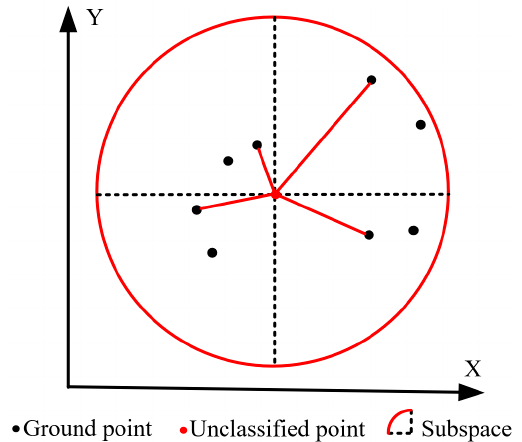
Figure 8. Schematic diagram of the identification for evenly distributed neighbor ground points. The implementation steps include point cloud attribute initialization, ground seed identification, and ground point extraction. First, the attributes of all points in the point cloud are marked as unclassified points. Second, unclassified points are regarded as ground seeds if the distances between the points and the detected planes are less than a buffer difference threshold. The attributes of identified ground seeds are modified to ground points. Third, the neighbor ground points of an unclassified point are searched from multiple subspaces. The local reference terrain is constructed based on the searched ground points using the least-squares plane fitting method. The unclassified point is marked as ground point if the distance between the point and the local reference terrain is less than a classification distance threshold. Step 3 is repeated until no points are classified as ground points.